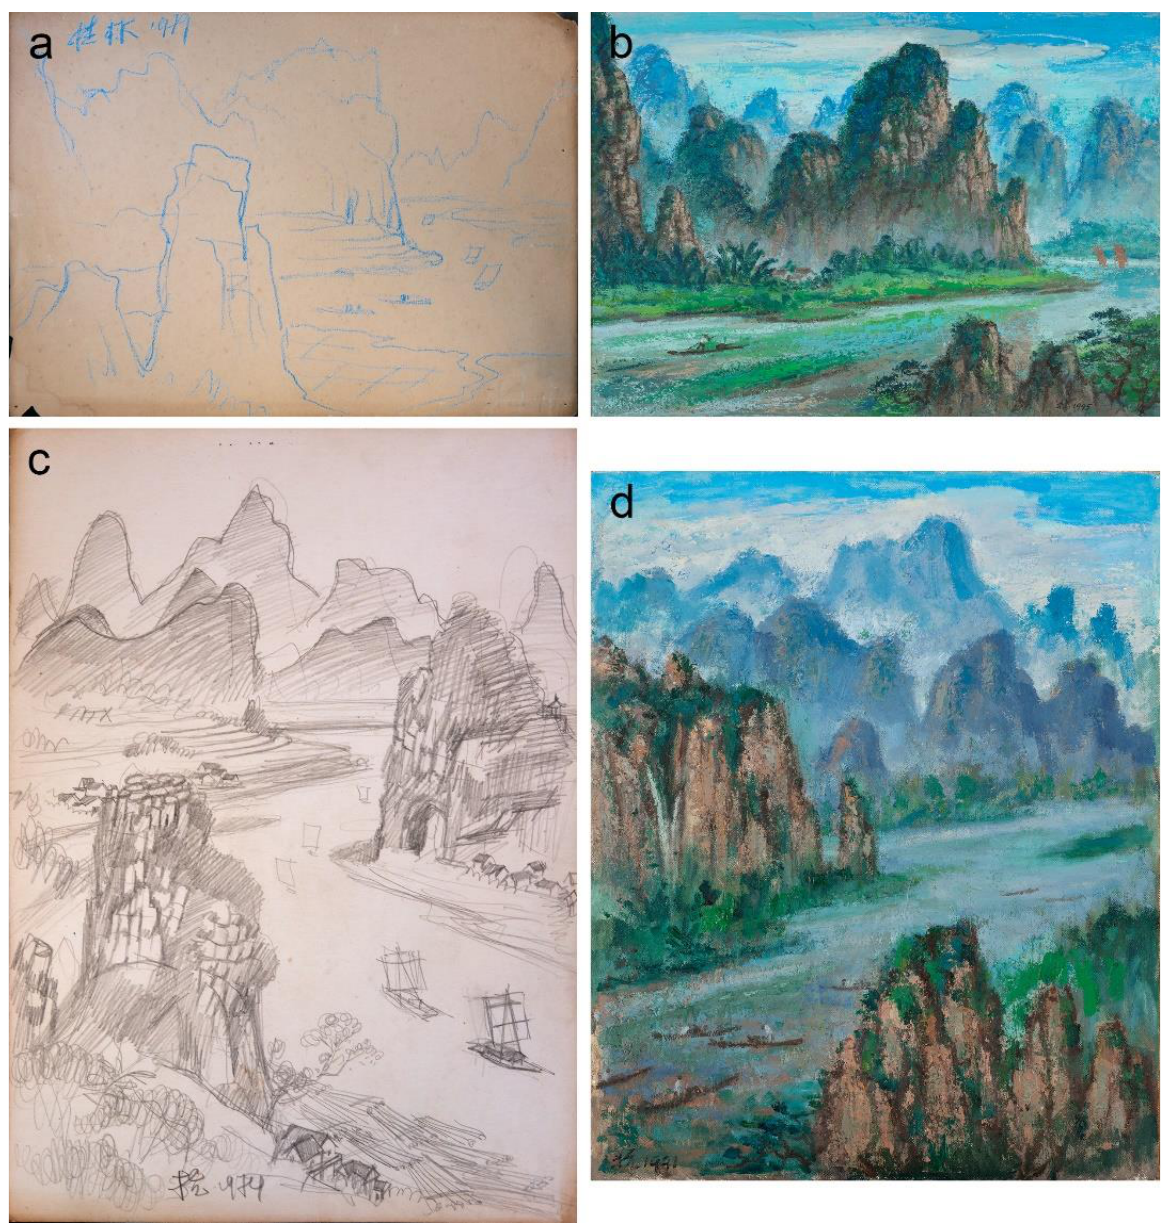
Figure 18. ( a ) Liu Kang, untitled, 1979, crayon on paper, 38 × 28 cm; ( b ) Liu Kang, Mountain , 1995, oil on canvas, 84.7 × 118.5 cm; ( c ) Liu Kang, untitled, 1979, pencil on paper, 38 × 28 cm; ( d ) Liu Kang, Mountains , 1991, oil on canvas, 76.5 × 61 cm. Images ( a , c ) are from Liu Kang family collection. Images courtesy of Liu family. Images ( b , d ) are gifts of the artist’s family. Collection of National Gallery Singapore.